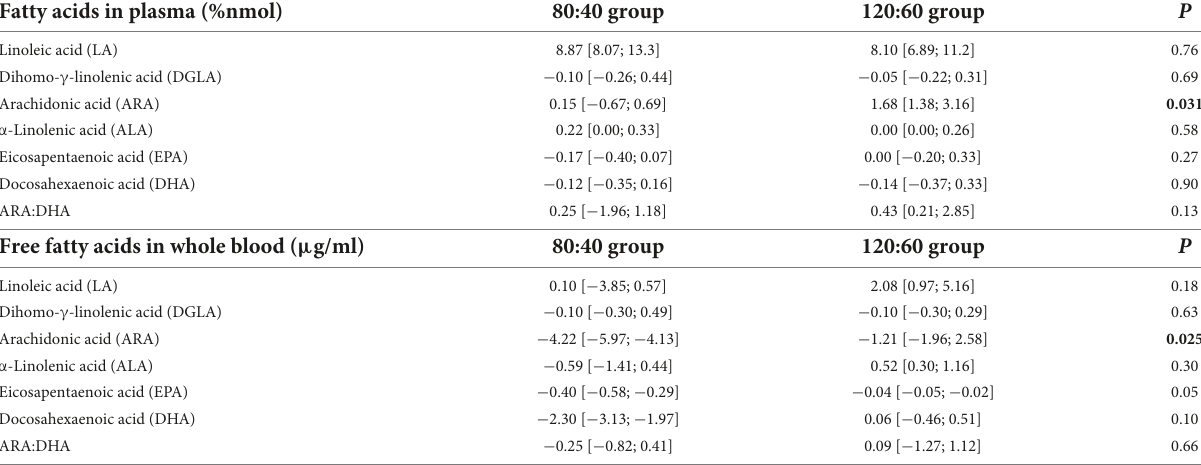
TABLE 2 Changes in total plasma and free whole blood LCPUFAs from birth to 36 weeks’ postmenstrual age according to the ARA:DHA group supplementation. Fatty acids in plasma